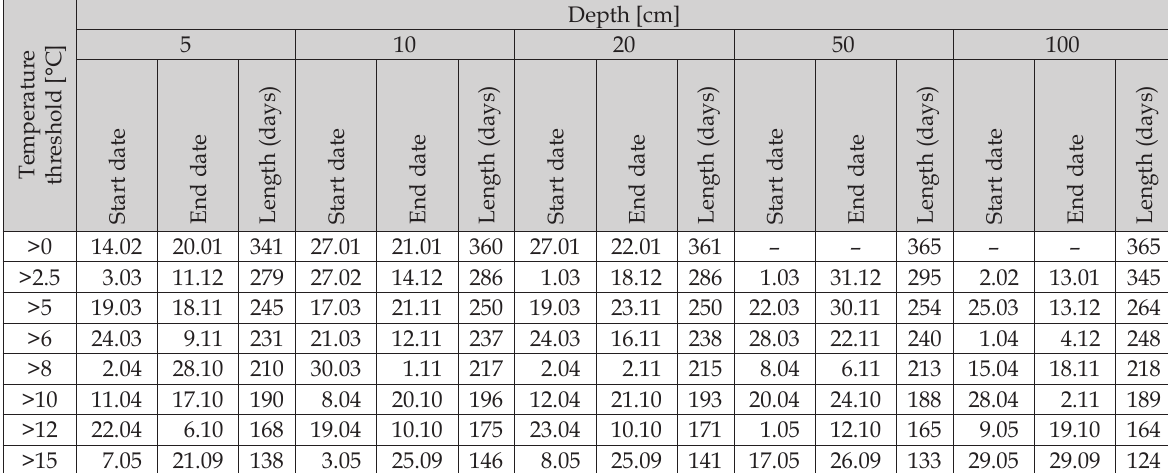
Table 7. Average start and end dates and the length of the particular periods with temperature thresholds at various depths in Poznań (2011–2020).